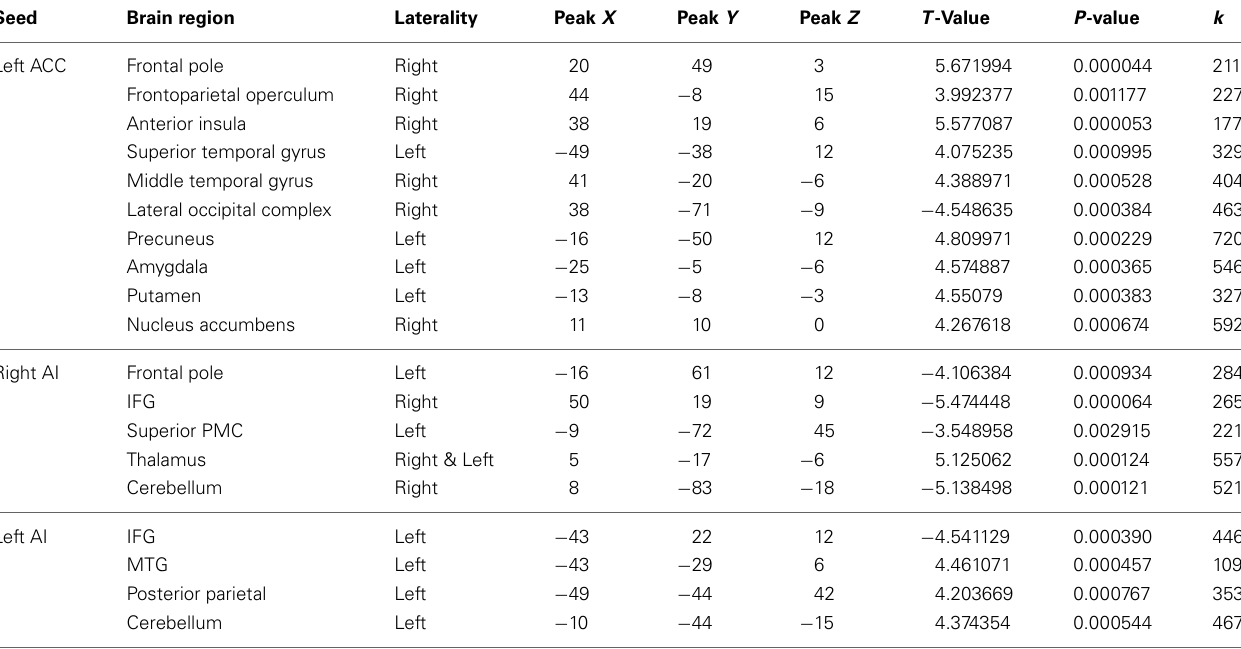
FIGURE 5 | Brain regions correlated with activity in the left ACC using PPI analysis. Regions shown represent regions that are more greatly connected to ACC activity while viewing hateful people in Table 4 | Peak voxel Talairach coordinates from regions functionally connected to the ACC during pain processing in likable and hateful targets. Seed Brain